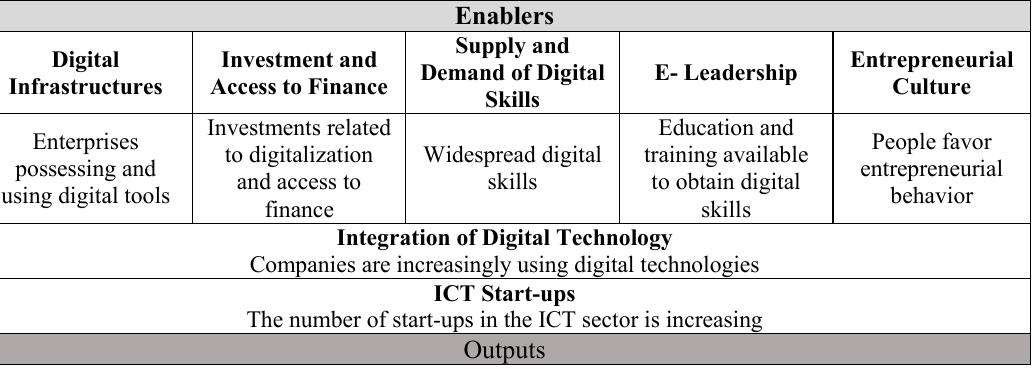
Fig. 1. Indicator-Based Monitoring of Digital Transformation Source: Digital Transformation Scoreboard